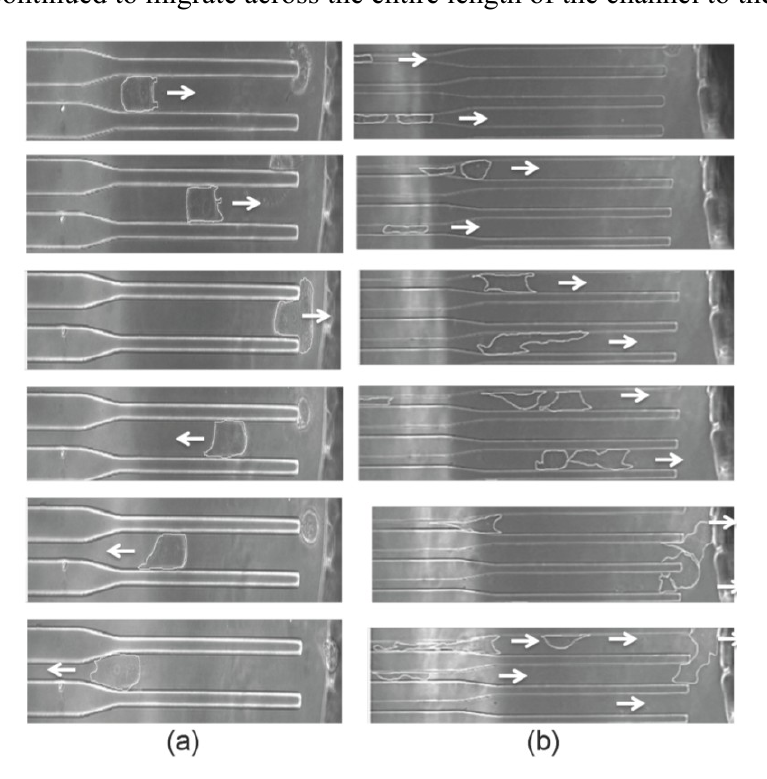
Figure 4. Time-lapsed microscopic images of migration behaviors for ( a ) PC-3 cells and ( b ) PNT1A cells, when seeded on the narrow end with EGF (75 ng/mL) in the chamber on the wider end. As indicated by the arrows, PC-3 cells re-entered the channels, while PNT1A cells continued to migrate across the entire length of the channel to the other side.